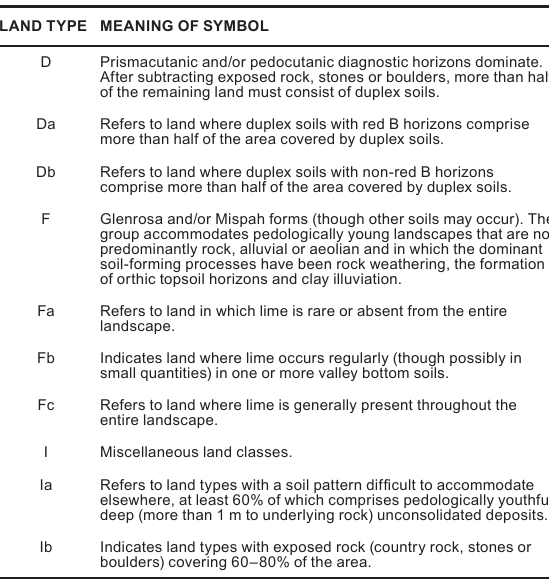
TAble 2 Land type symbols and their meaning within the text (Du Plessis